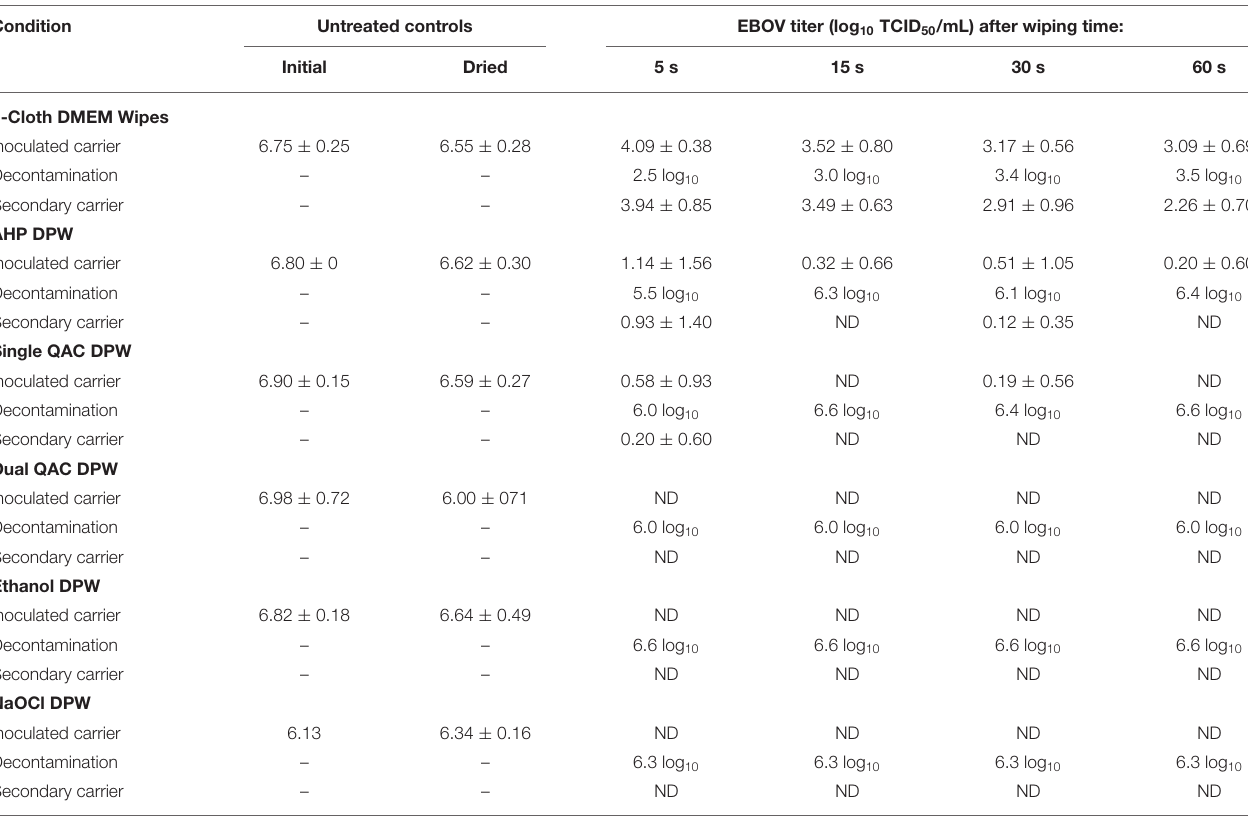
TABLE 1 | Efficacy of disinfectant-impregnated wipes (DPW) vs. DMEM-impregnated J-Cloth wipes for removal/inactivation (decontamination) or transfer of EBOV * .